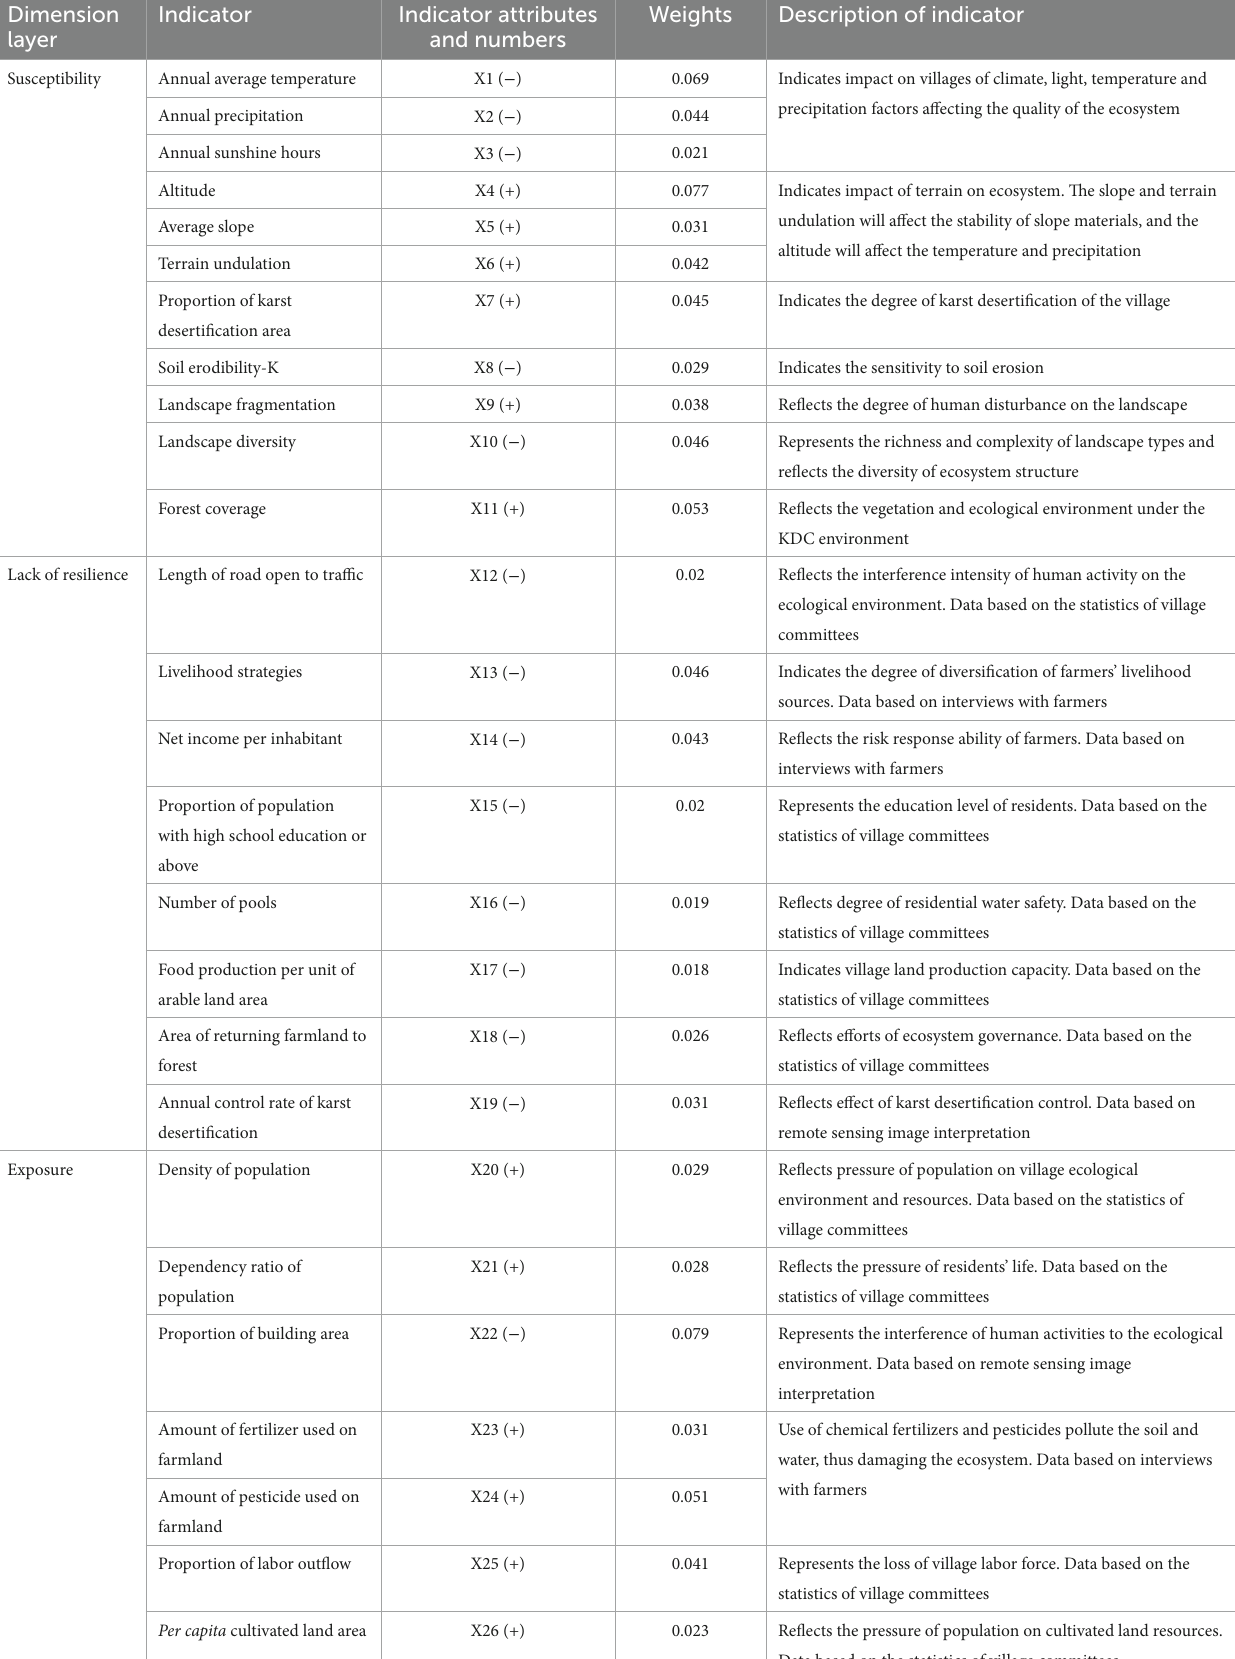
TABLE 1 Village ecosystem vulnerability indicator